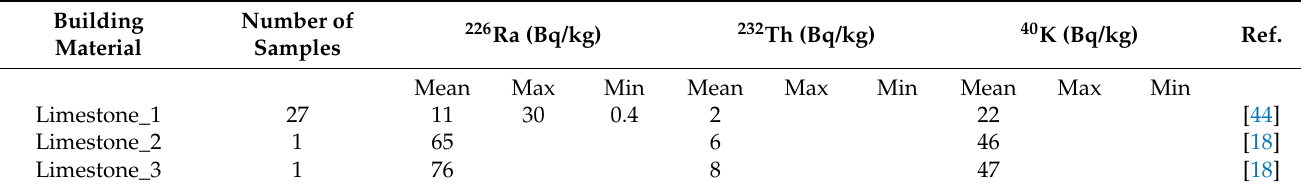
Table 3. Activity concentration of the radionuclides measured in the limestone listed in the ISTISAN report 17/36.